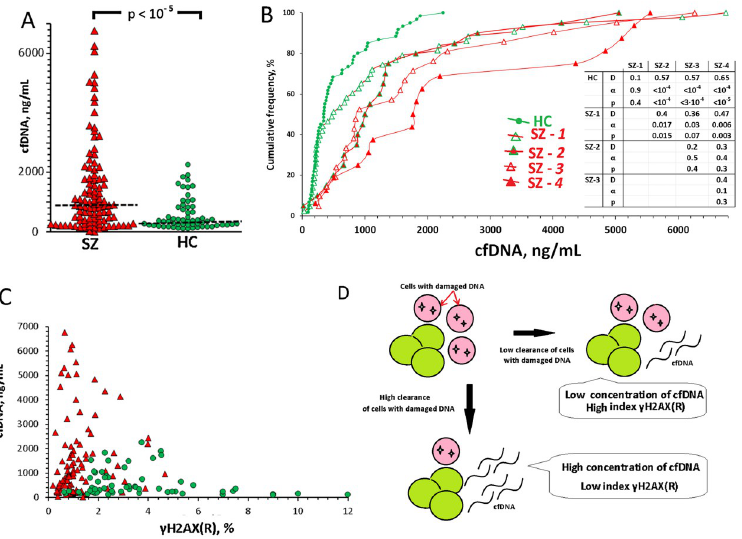
Fig 5. Concentration of the circulating cell-free DNA (cfDNA) in blood plasma. A. Concentration of the cfDNA in SZ- and HC groups. B. Cumulative distribution cfDNA for HC and SZ subgroups. The significance of the observed differences was analyzed using the non-parametric Mann–Whitney test (p) and Kolmogorov–Smirnov test (D and α ). C. Dependence of cfDNA concentration in blood plasma on the size of lymphocyte fraction γ H2AX (R) with damaged DNA. D. Scheme illustrating the change in the ratio of the size of the cell fraction γ H2AX (R) and the concentration of cfDNA.